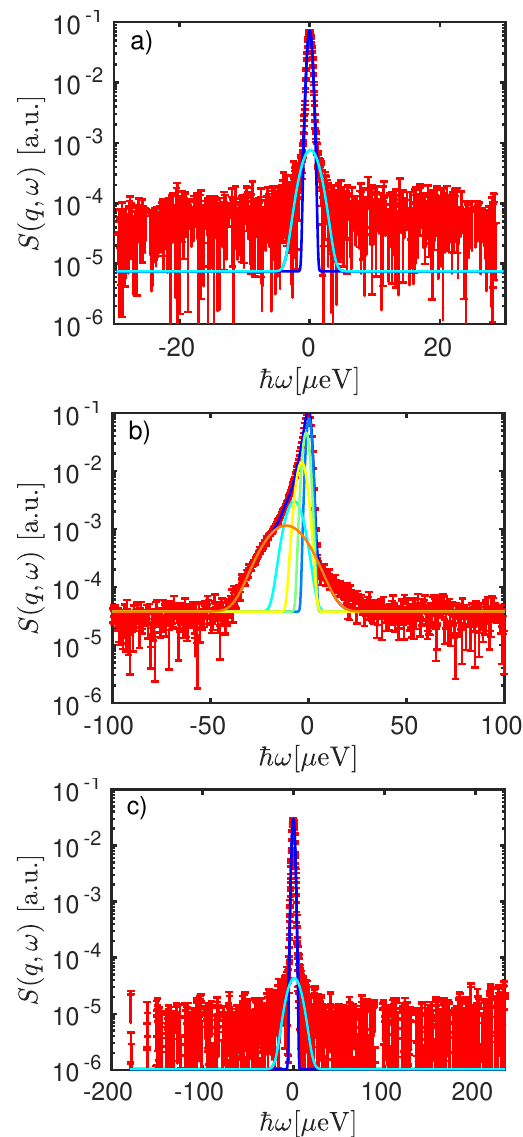
Figure 1: Resolution functions of different instruments (red symbols) and corresponding fits with the different Gaus- sian functions (colored lines). Different vanadium samples were measured with different statistics as well as different geometries, and different q and ℏ ω binnings are applied. A direct comparison between the instruments is therefore not possible. In contrast, the present and subsequent fig- ure illustrate the generality of the analysis approach. For the different instruments, a different number n of Gaus- sian functions was used in addition to a flat background. a) IN16b: n = 2 ; q = 1 . 03 Å − 1 b) BASIS: n = 5 ; q = 1 . 05 Å − 1 c) BATS: n = 2 ; q = 1 . 03 Å − 1 . Details of the binning ap- plied are given in Table